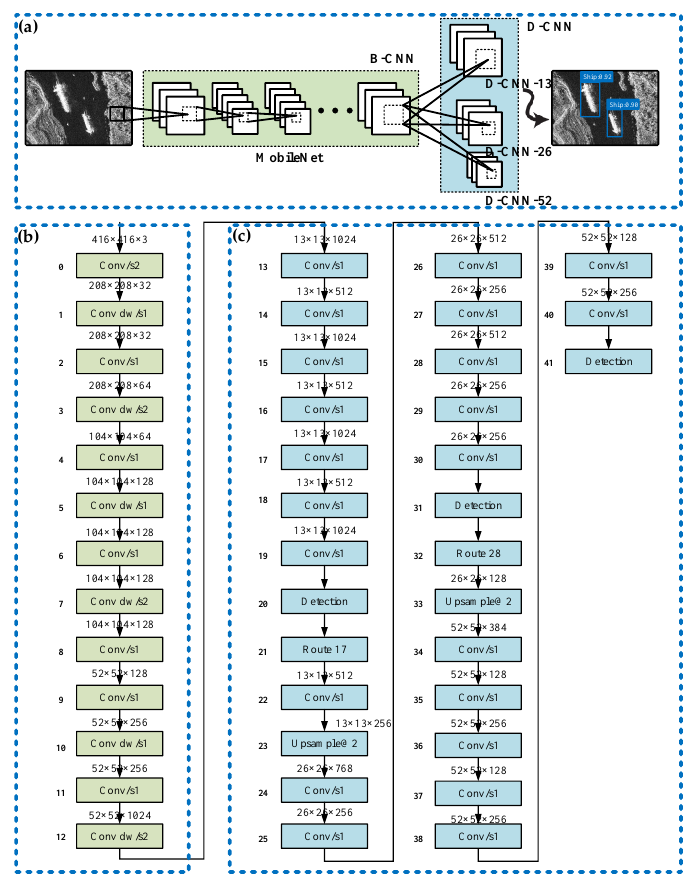
Figure 4. The grid convolutional neural network (G-CNN) ship detection system. ( a ) Overall framework; ( b ) backbone convolutional neural network (B-CNN); ( c ) detection convolutional neural network (D-CNN).